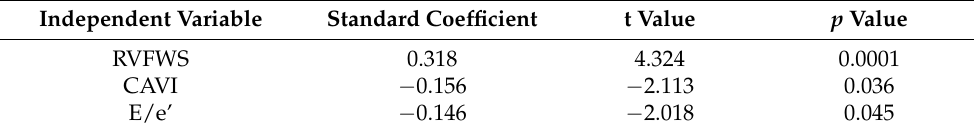
Table 4. Multiple regression documenting the association of RA conduit strain with clinical variables. Independent Variable Standard Coefficient t Value p Value RVFWS 0.318 4.324 0.0001 CAVI − 0.156 − 2.113 0.036 E/e’ − 0.146 − 2.018